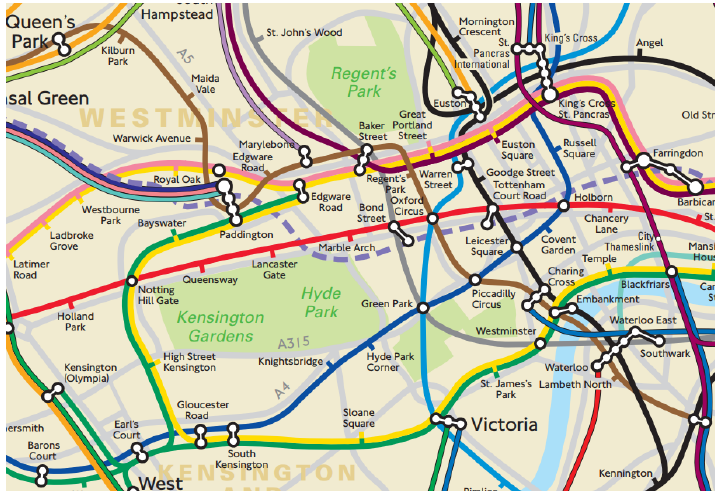
Figure 2. A part of the actual physical underground network in central London embedded on a map: The distance between consecutive stations is